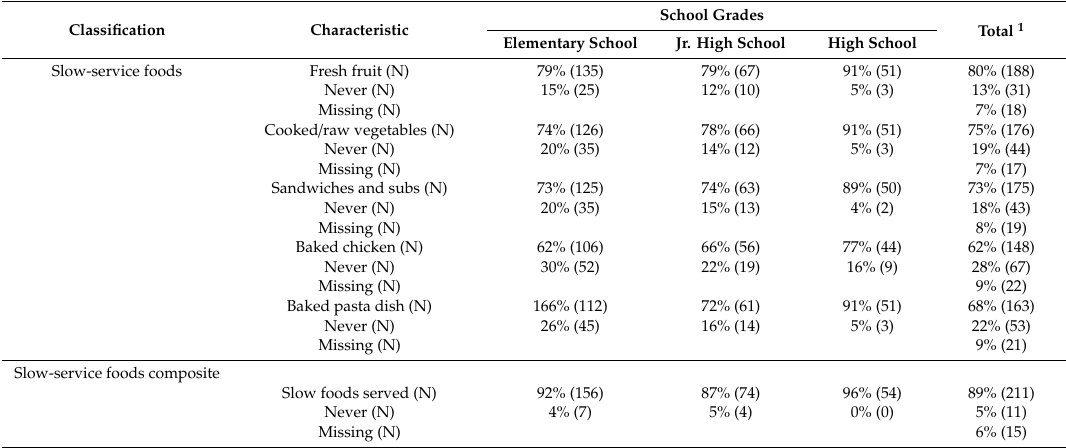
Table 1. School characteristics for analytical samples by grades within each school, N = 237 1 .